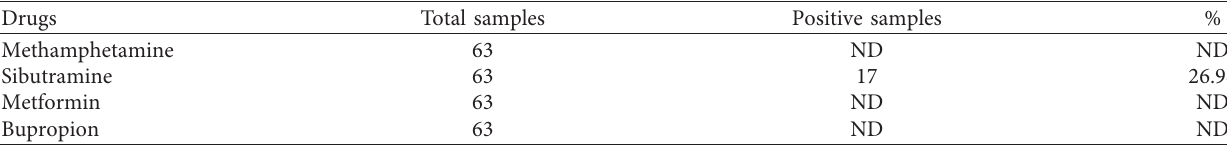
Table 1: Preliminary examination on samples using the TLC